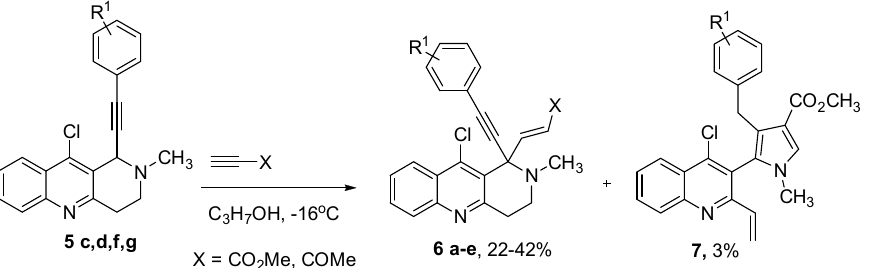
Scheme 4. The reaction of compound 5c , d , f , g with activated alkynes. Table 2. Compounds 6a – e with related reaction yields.